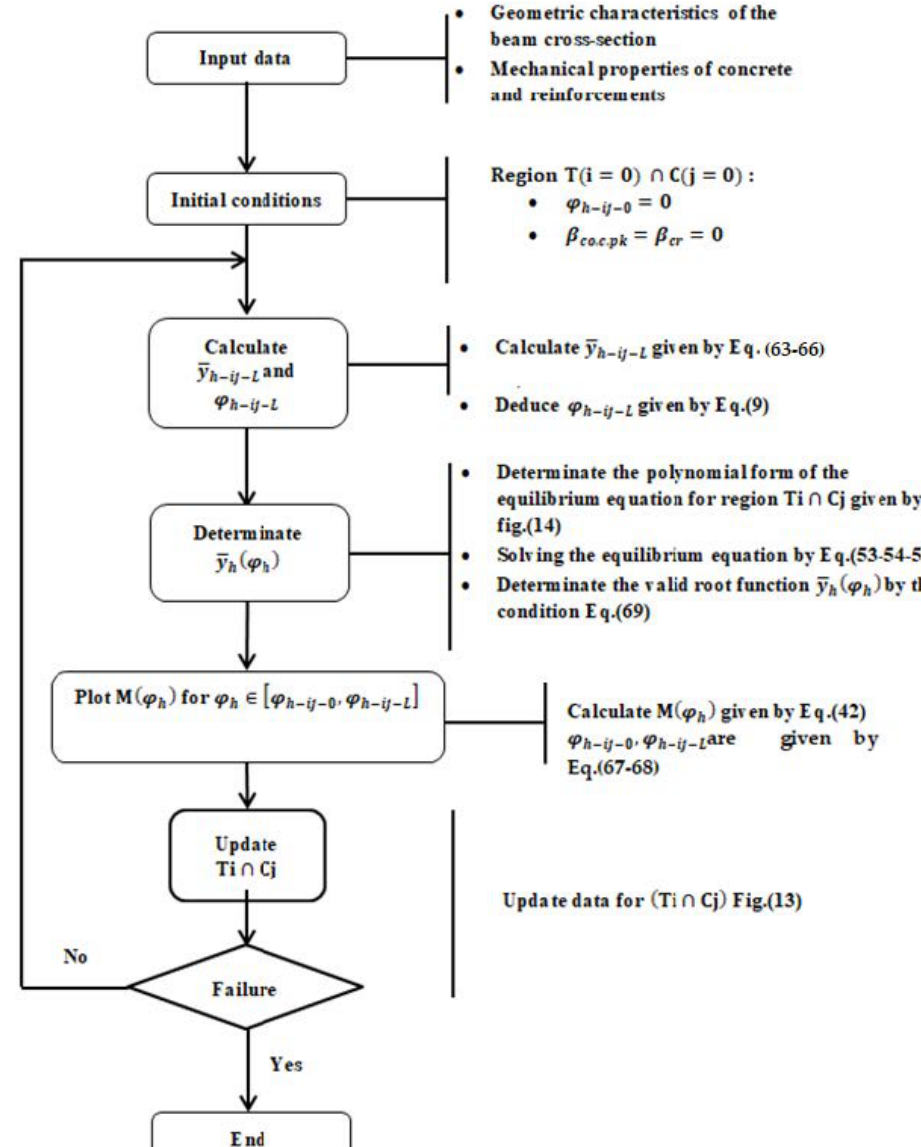
Figure 16. An algorithm to generate the moment–curvature relationship.